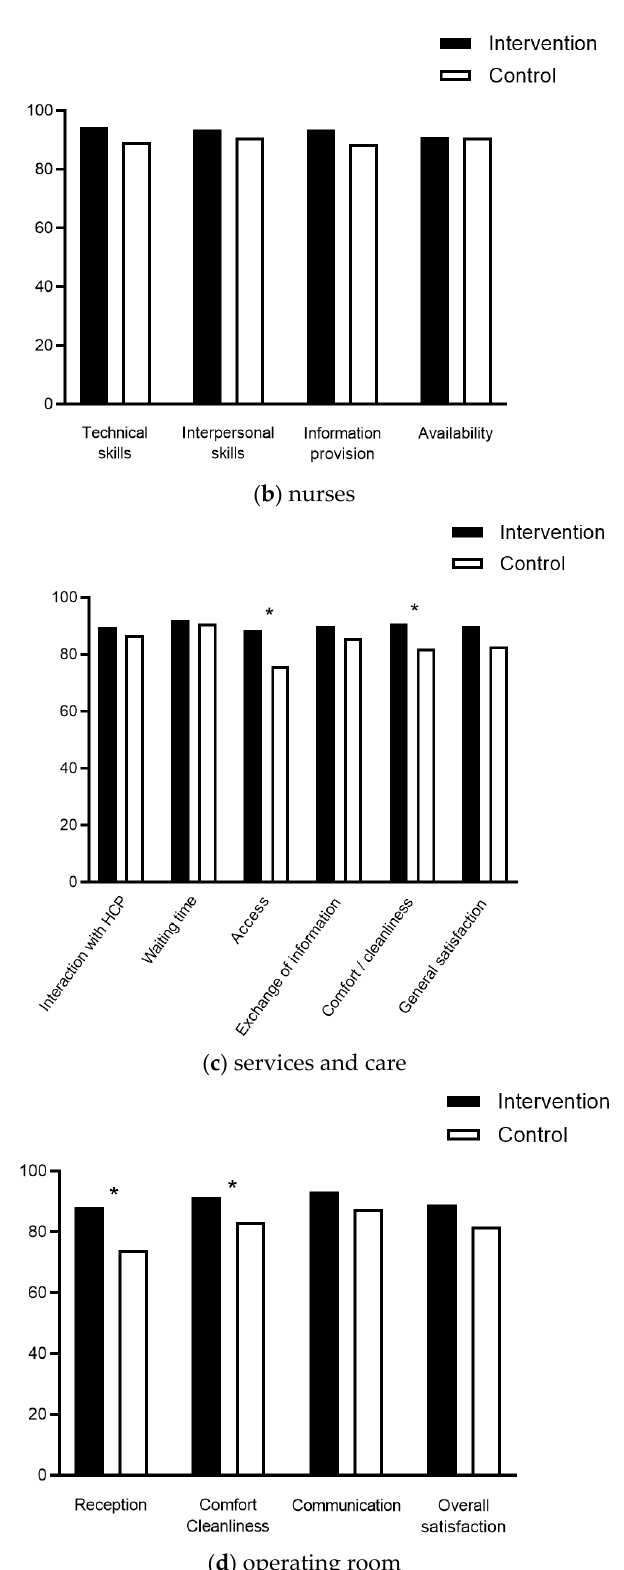
Figure 4. Patient satisfaction. Patient satisfaction scores ( y -axis) (EORTC In-Patsat32 questionnaire) regarding: ( a ) doctors; ( b ) nurses; ( c ) hospital services and care; and ( d ) operating room facilities comparing patients in the intervention group (black bars) and patients in the control group (white bars). Displayed are mean scores. * indicates statistical significance ( p > 0.05). HCP: Healthcare